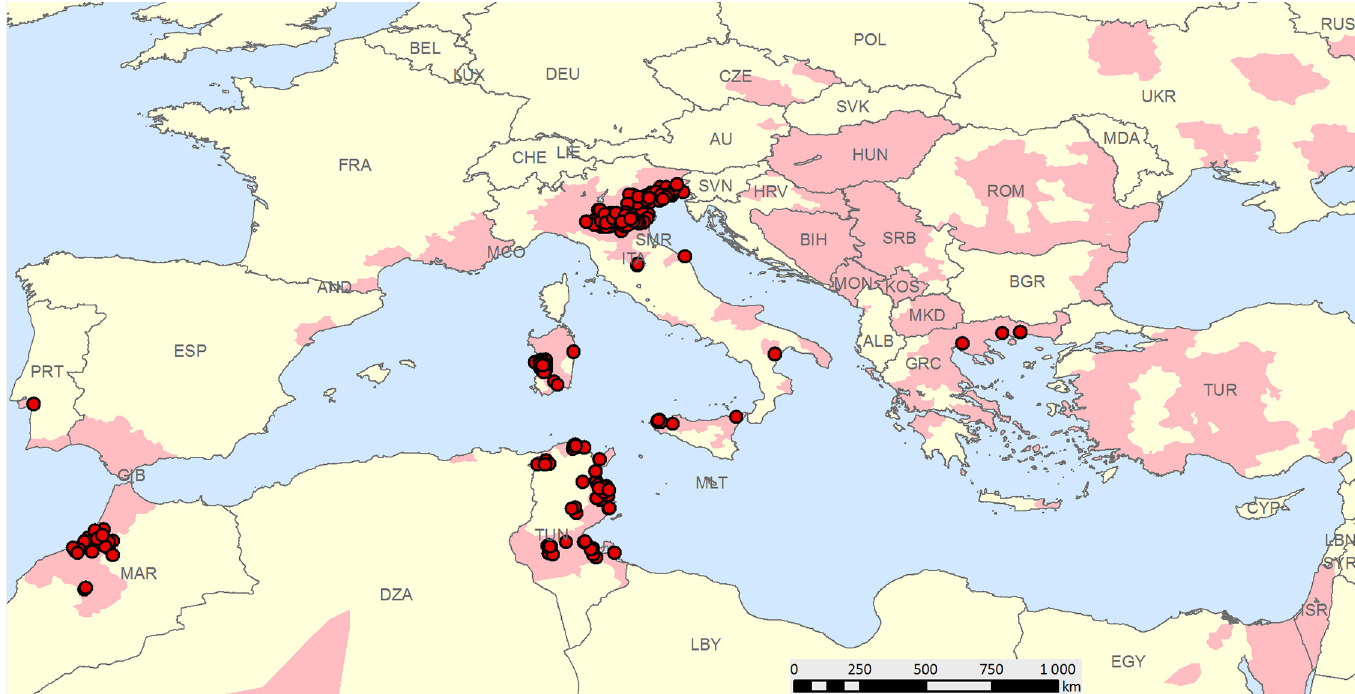
Fig 1. Study area: distribution of reported West Nile virus by country, region, and province since the 90s (light red polygons) and case locations included in the study between 2008 – 2012 (red points).